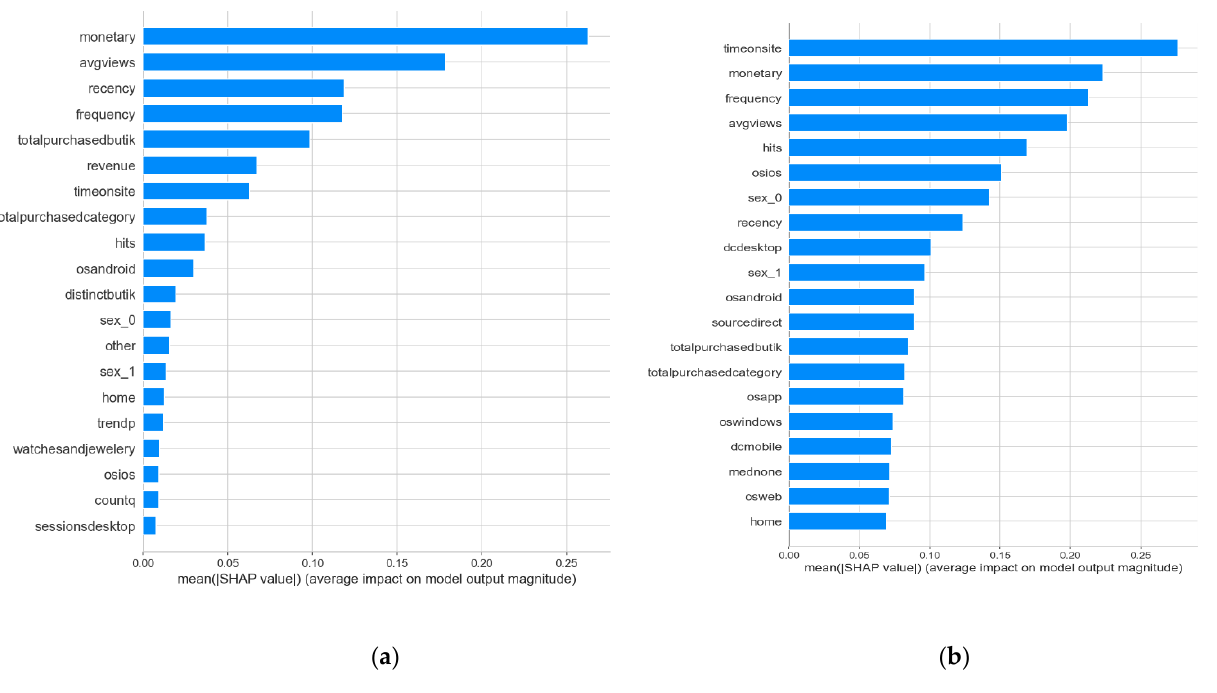
Figure 4. Feature importance levels defined by average SHAP values for Customer Lifetime Value (CLV). ( a ) Multi-output model CLV SHAP values, ( b ) single-output model CLV SHAP values.